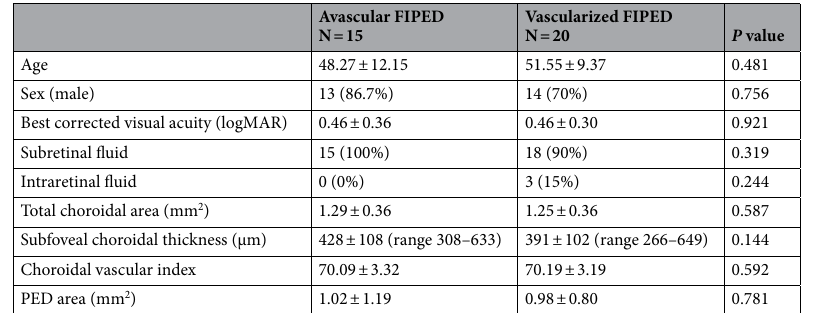
Table 1. Baseline characteristics of patients with aFIPED and